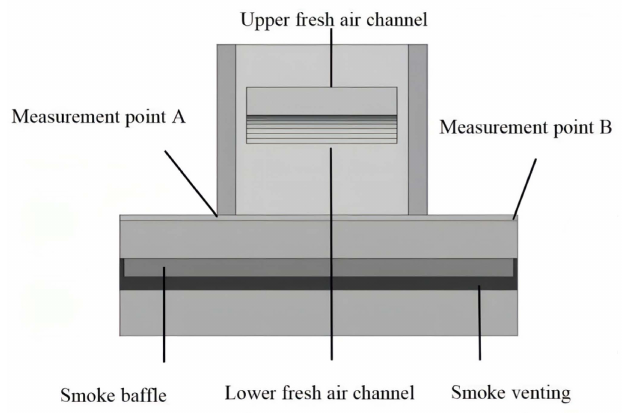
Figure 6. Location of measurement points A and B.